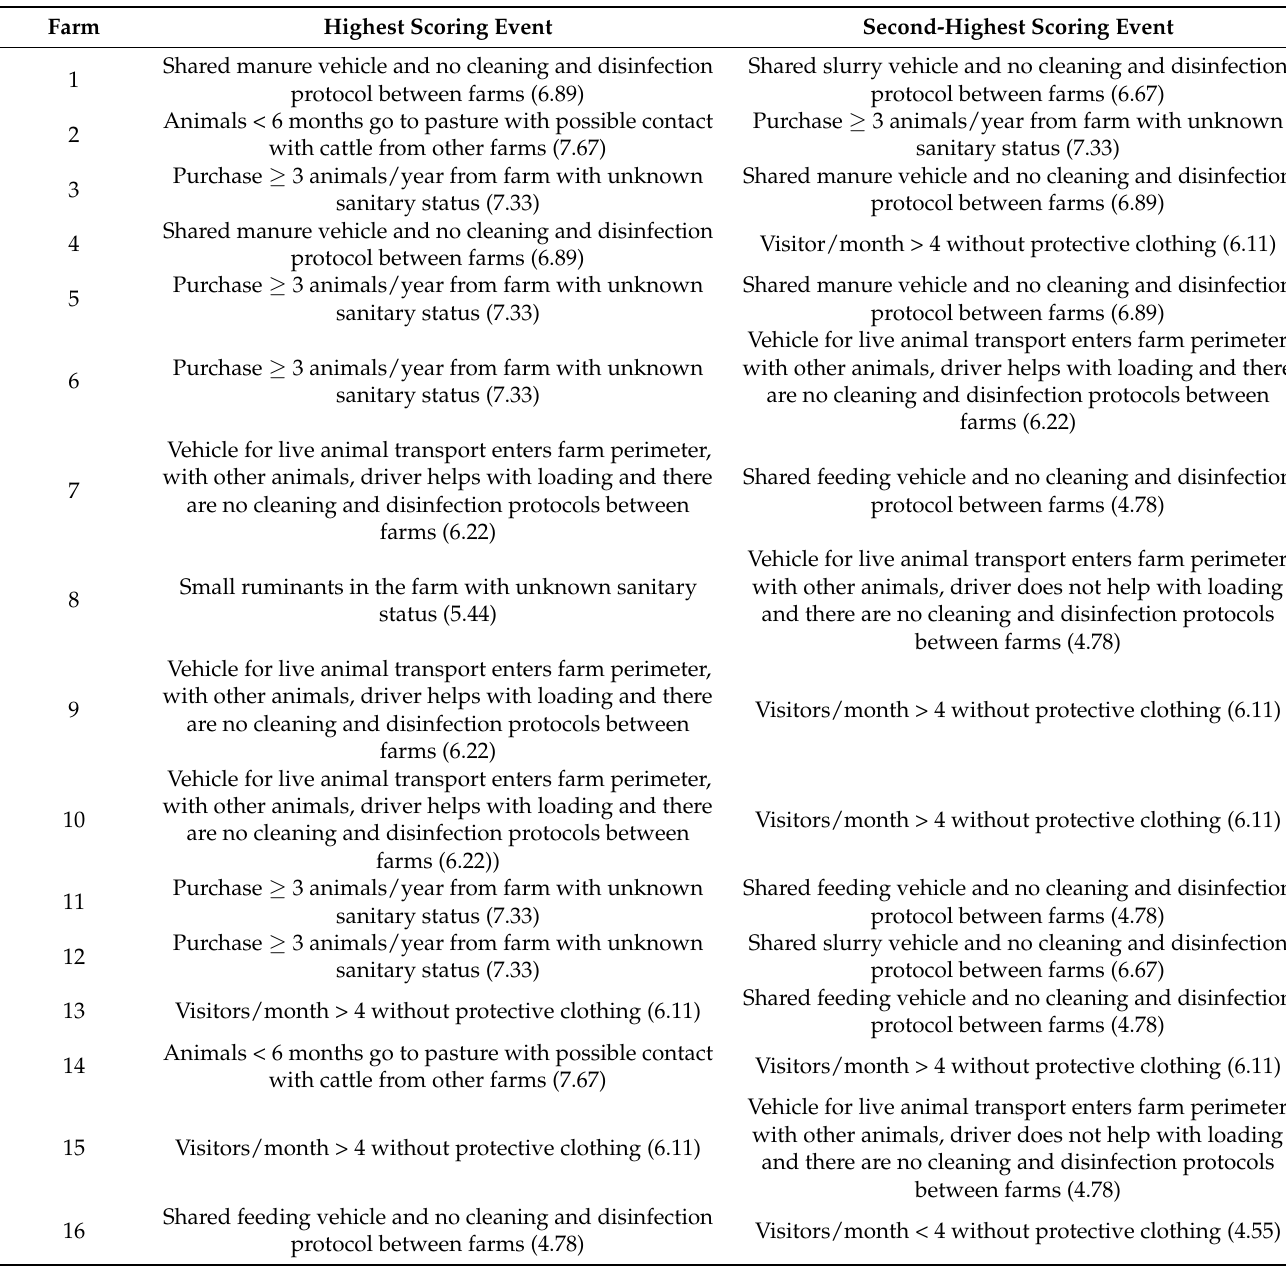
Table 3. Highest two scoring events according to the mean values assigned by the expert group in the 16 infected farms in Galicia (mean score assigned to this